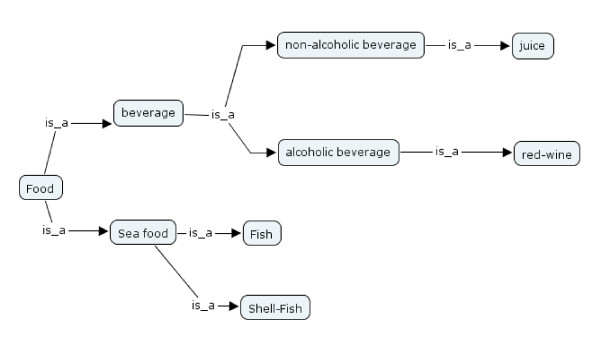
Elicitation of Is_a, whole/part-of, and classes.